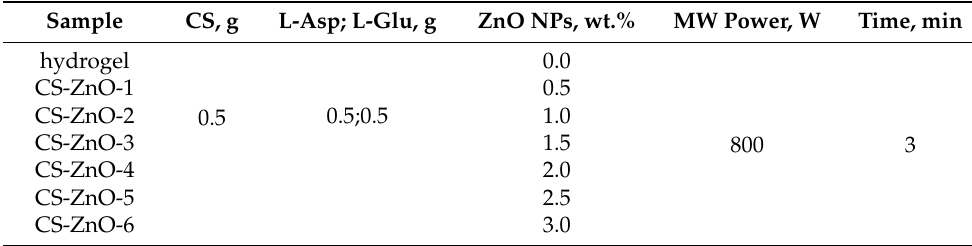
Table 1. Transdermal delivery systems